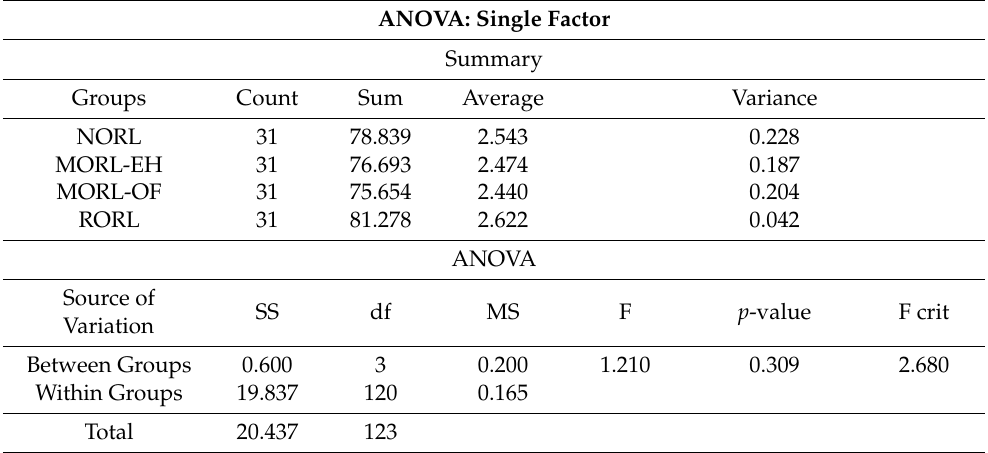
Table 9. Summary of the ANOVA results from the 1 m per day drawdown rate. ANOVA: Single